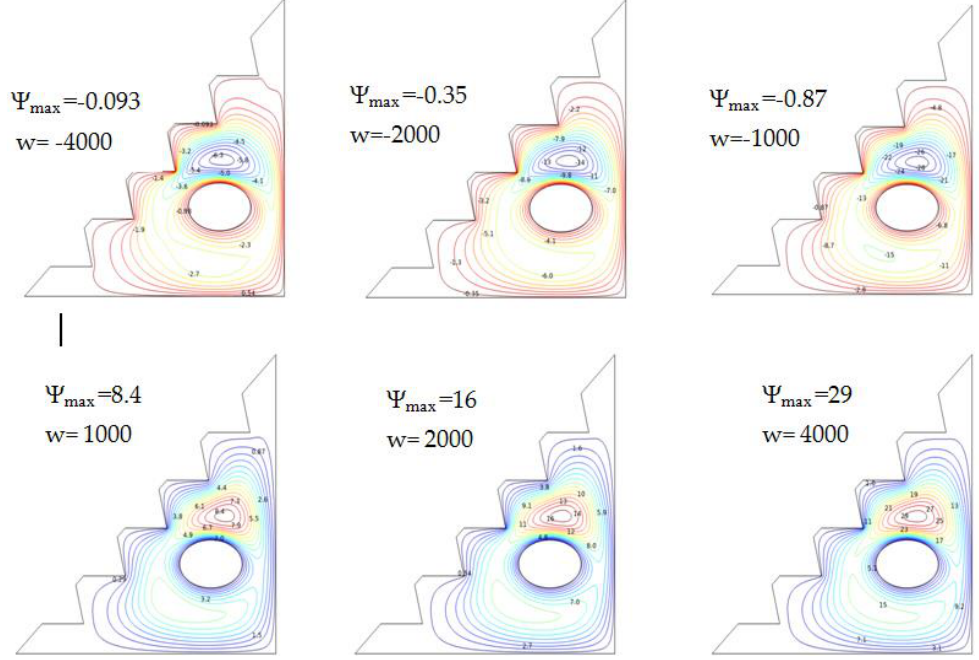
Figure 9. Streamlines via w and Ra = 10 5 , ϕ = 0.04, and Ha = 0. Leading the cylinder counter-clock wise reveals the benefits of the convective